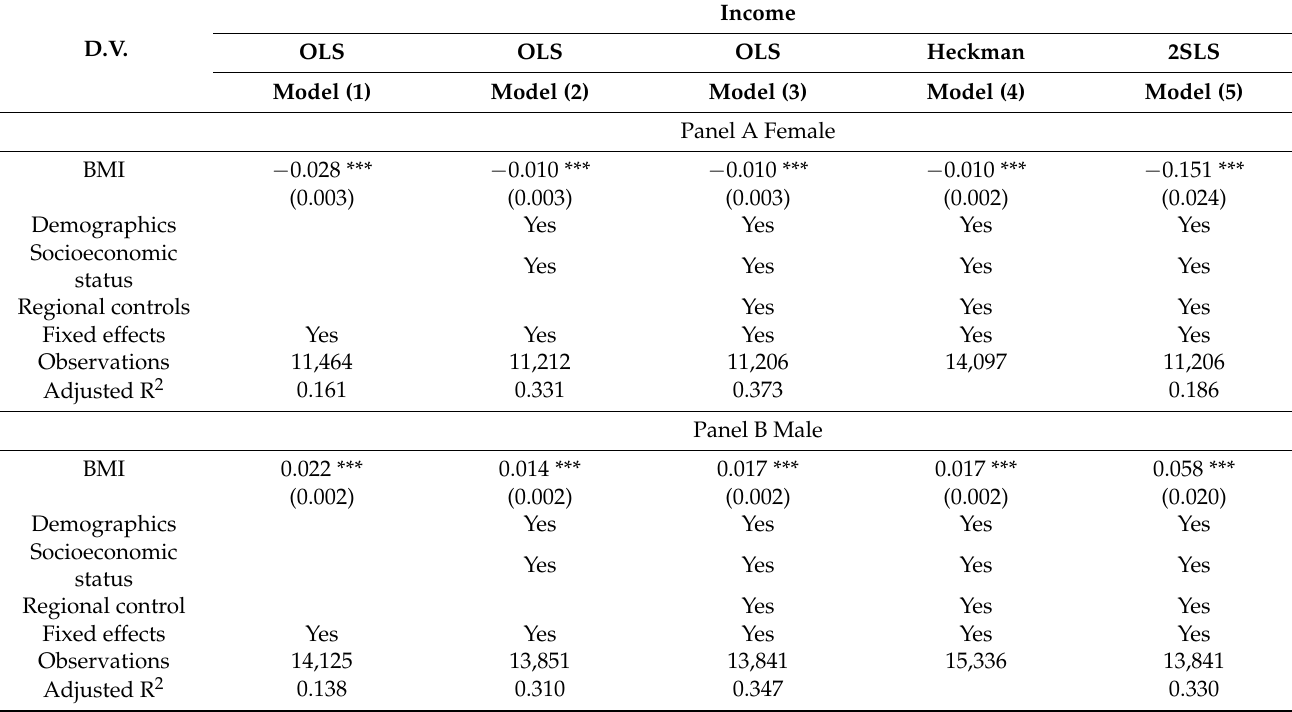
Table 3. Regression results of BMI: the pros and cons of